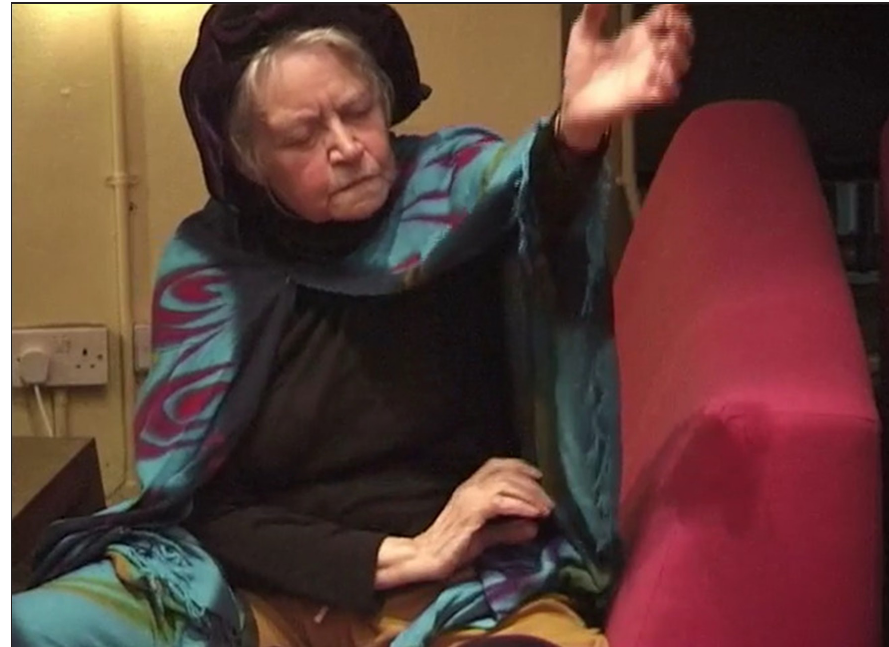
Figure 2.2: (49.00) Jennifer Pike with Birdyak at the RCA, London 2002. Courtesy of William Cobbing.